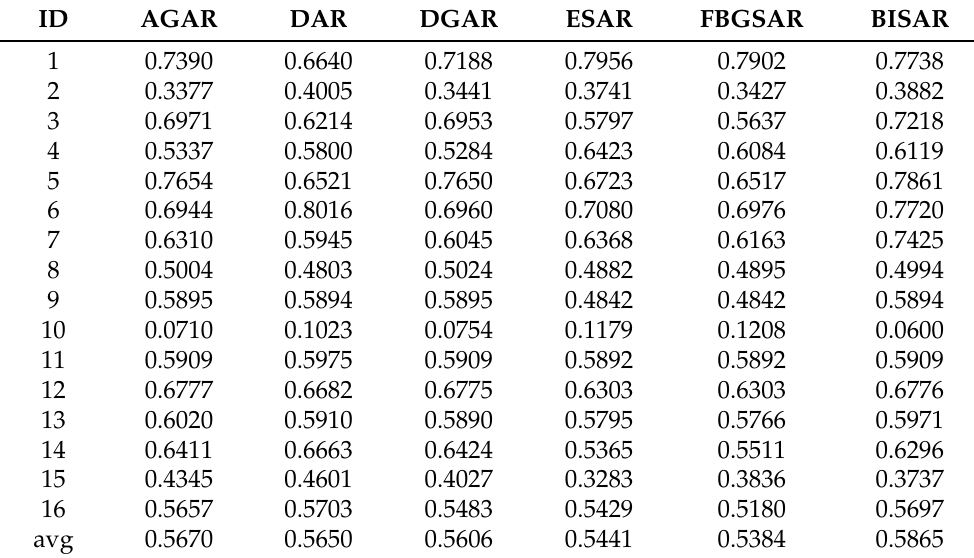
Table 13. Classification accuracies based on SVM classifier (feature